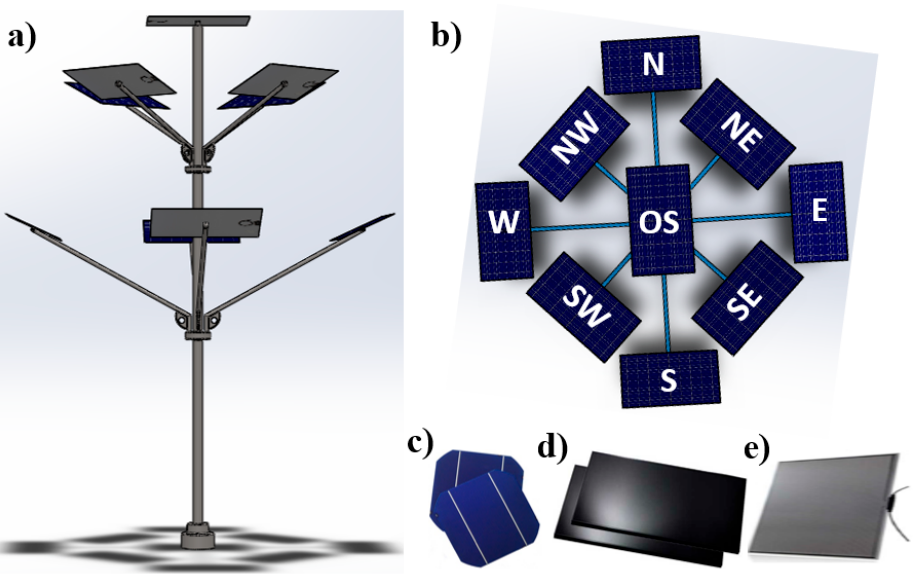
Figure 2. The schematic structure of the solar photovoltaics tree (SPVT): ( a ) Three-layered SPVT; ( b ) SPVT showing the PV leaf arrangement; ( c ) c-Si PV cells; ( d ) CIGS PV cells; ( e ) CdTe PV cells. The arrangement of the PV leaf on each branch of the SPVT, along with its direction, is shown in Figure 2b. A PV leaf is arranged on each branch of the SPVT, as the physical constraints related to shadowing were also considered. Here, the PV branches are placed to avoid such shadowing, and hence in each layer, a 2 m height di ff erence is considered; the PV leaves are mounted in di ff erent orientations, ◦ having exactly a 45 angle apart in a way that no panel is oriented to same direction, irrespective of the layer. Finally, these branches are exposed to the sunlight and ultimately generate electricity. Table 2. Installation configuration of photovoltaic leaves in the three-layered solar photovoltaic tree. Solar Tree PV Leaf